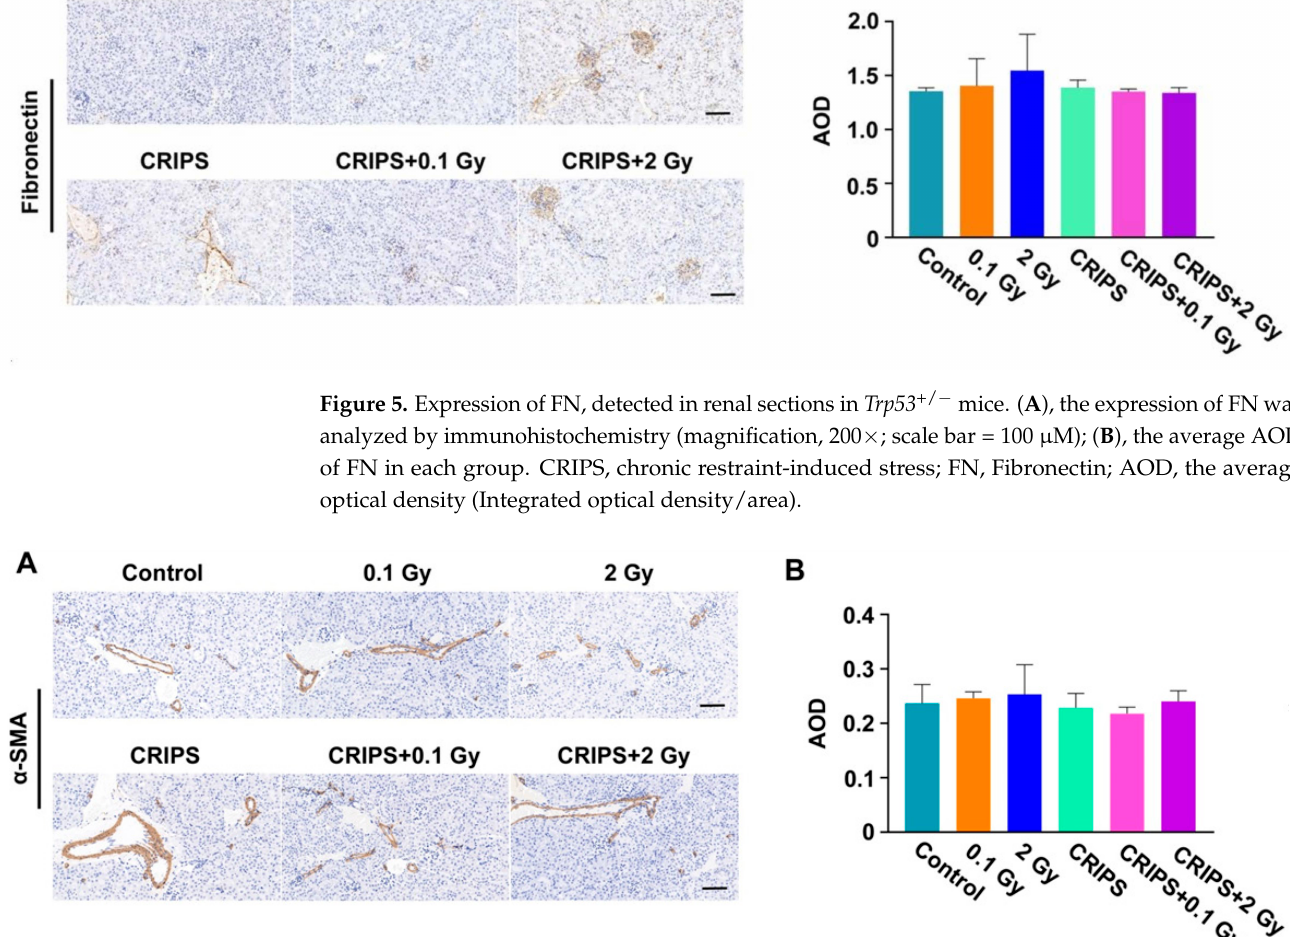
Figure 7. Expression of α -SMA, detected by Western blotting in Trp53 +/ − mouse kidneys. A , the representative images of Western blotting, three replicates in each group; B , the relative expression of α -SMA in each group. CRIPS, chronic restraint-induced stress. * p < 0.05; ** p < 0.01. 4. Discussion Radiation-induced fibrosis is a late sequela of both therapeutic and accidental irra- diations, which has been described in various tissues, including the lung, liver, kidney and skin [27]. The altered renal lipid metabolism induced by chronic restraint stress may contribute to renal injury [12]. Thus, the harmful effects from concurrent exposure to IR and PS on renal injury and fibrosis cannot be ignored during long-term space missions. The present study explored the effects of a low dose of 56 Fe ion radiation combined with CRIPS on renal fibrosis, and whether CRIPS might be an additive factor in the renal fi- brosis induced by IR in Trp53 +/- mice. Radiation nephritis (RN) is a clinical syndrome caused by acute or chronic kidney injury after IR. The effects in patients include fatigue, shortness of breath, edema and significant renal failure [3]. Chronic RN may be caused by the long-term evolution and aggravation of acute RN, including renal fibrosis [28]. In this study, we used a chronic restraint experimental device to generate a model of Trp53 +/- male mice exposed to 56 Fe radiation under PS, in which we observed the renal fibrosis. At the end of the 28-day experimental period, we conducted histochemical experiments on the renal tissue, which indicated no structural differences between the control group and the experimental groups. FN and α -SMA staining revealed no significant differences in fibrosis between the control group and the experimental groups, including the 2 Gy and CRIPS + 2 Gy